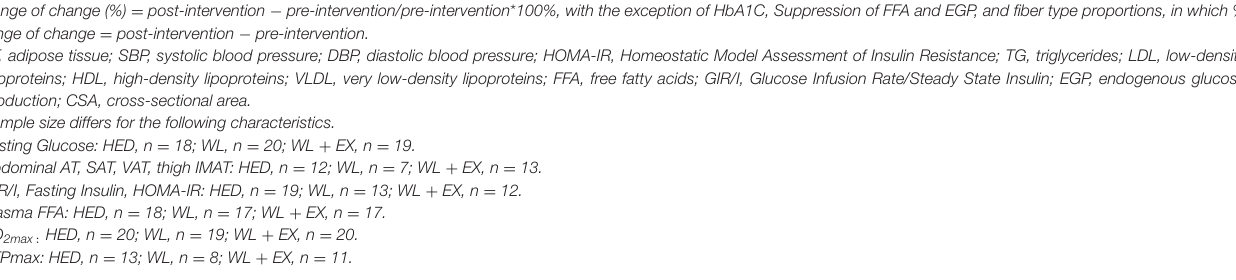
Frontiers in Endocrinology |